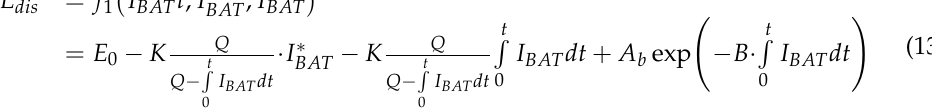
Figure 4. BAT model.